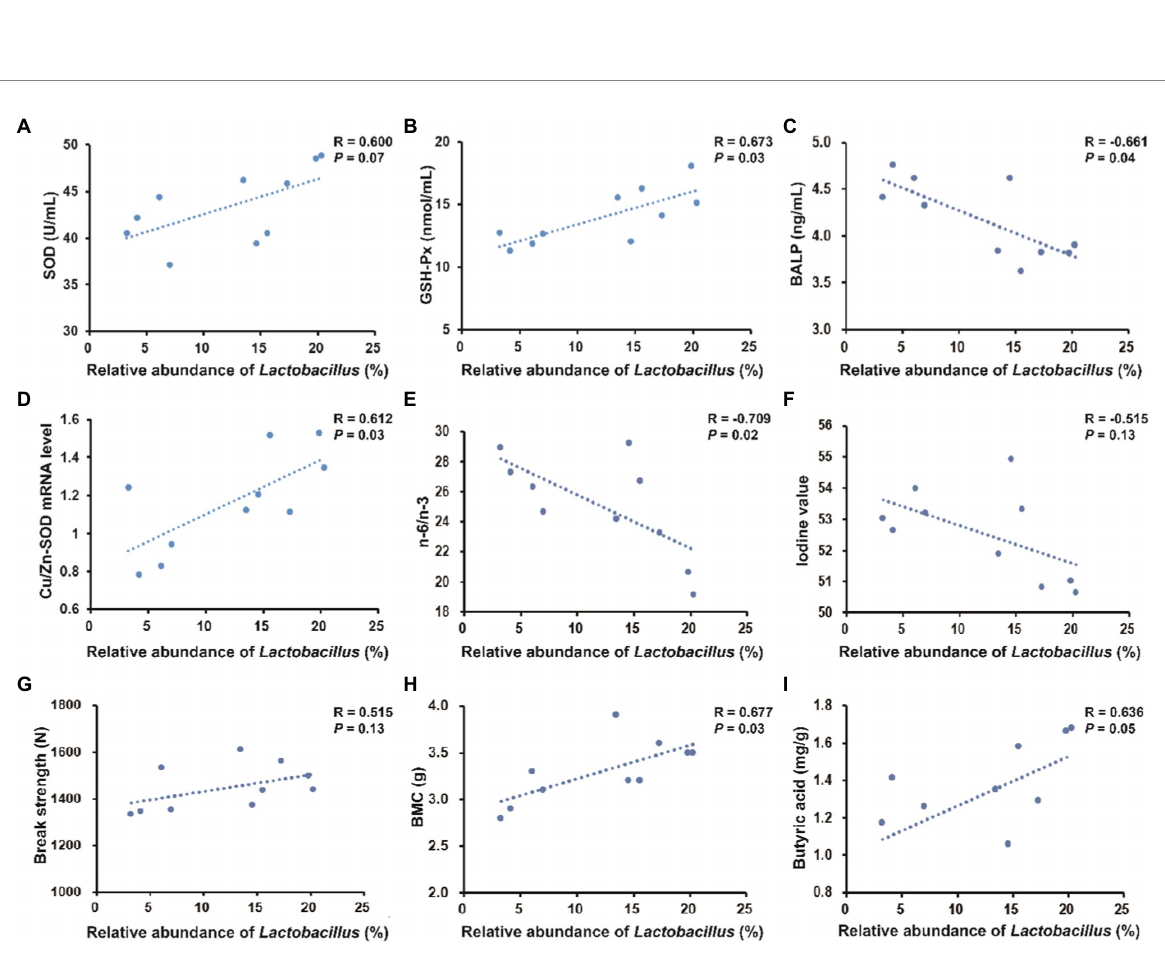
FIGURE 8 Spearman’s correlation between the relative abundance of Lactobacillus in the colonic digesta and serum parameters, pork quality parameters, bone parameters (take the third metacarpal bone for example) or colonic metabolites. (A–C) Correlation between the colonic abundance of Lactobacillus and serum parameters. (D–F) Correlation between the colonic abundance of Lactobacillus and pork quality parameters. (G,H) Correlation between the colonic abundance of Lactobacillus and bone parameters. (I) Correlation between the colonic abundance of Lactobacillus and butyric acid